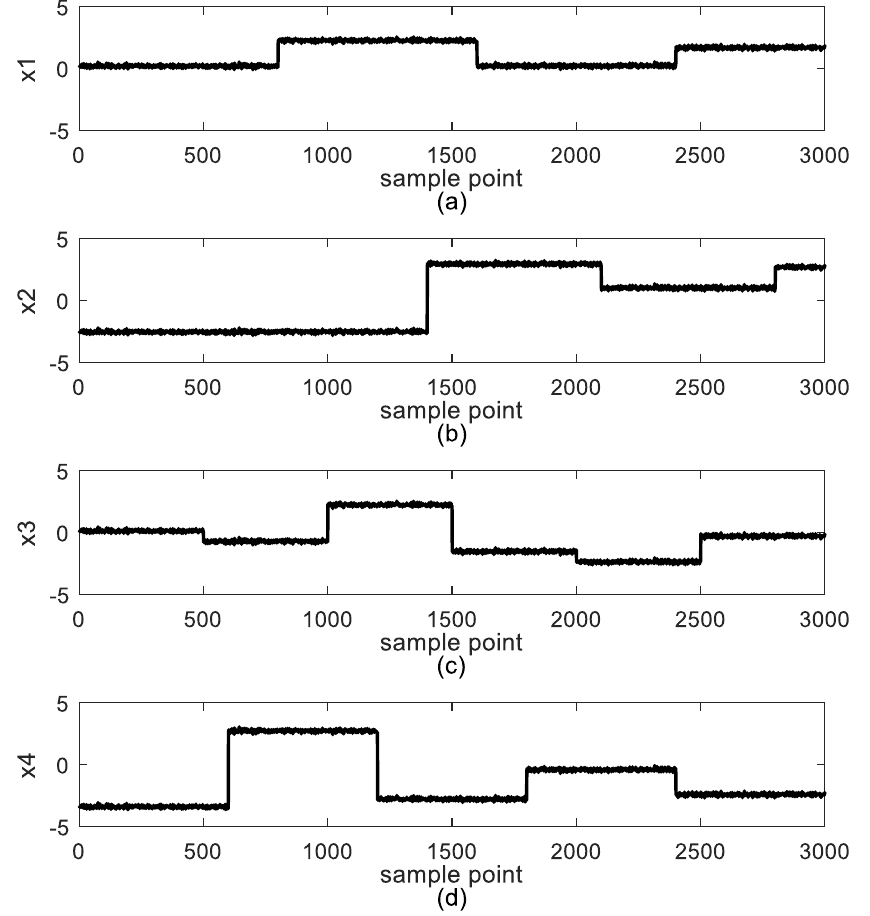
Figure 9. Input data set for polyethylene reaction: ( a ) x 1 —monomer feed flow; ( b ) x 2 —solvent ( n -hexane) feed flow; ( c ) x 3 —catalyst feed flow; ( d ) x 4 —gas recycle/monomer feed ratio.